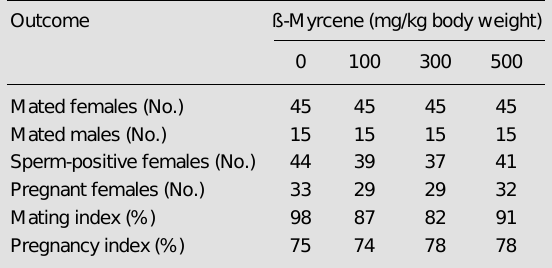
Table 2 - Outcome of fertility tests in rats continuously exposed to ß-myrcene (0, 100, 300 and 500 mg/kg) during the premating period.